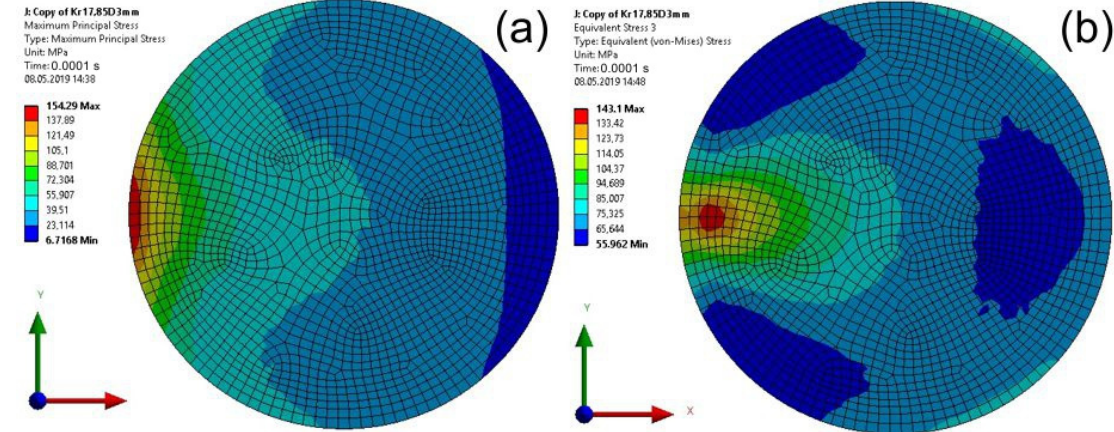
Figure 15. Map of the Main Principal Stress ( a ) and the von Mises Stress ( b ) in the adhesive layer for a computation time equal to 0.0001 s—Model no. 2 (linear analysis; maximal von Mises Stress is removed from the impact edge). The loads are applied in the direction of the X axis.